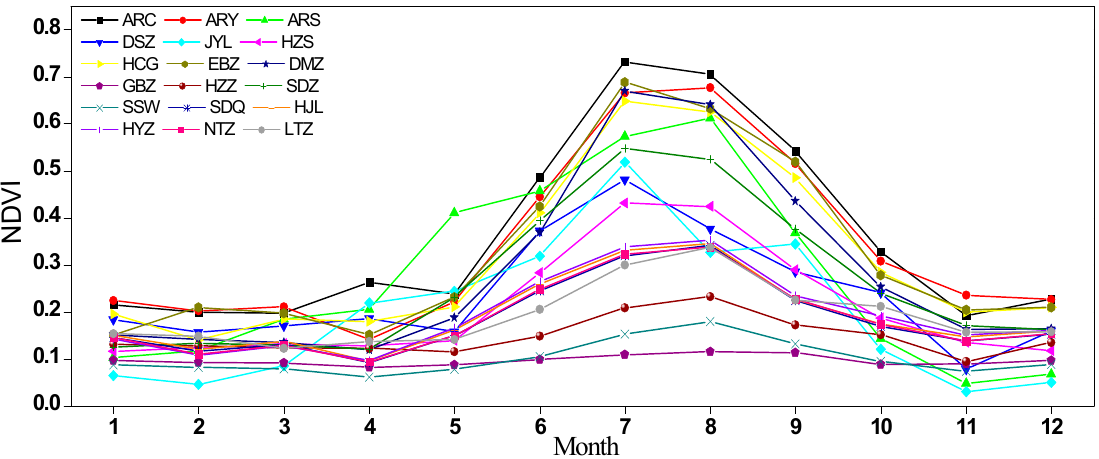
Figure 6. Monthly normalized difference vegetation index (NDVI) at the eighteen sites from 2013 to 2014.